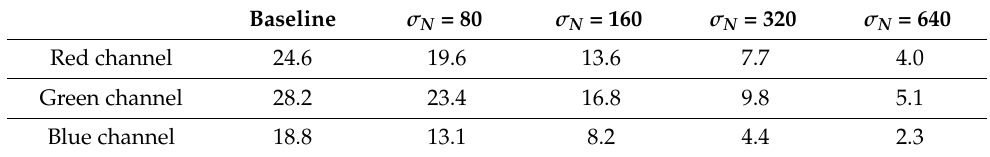
Table 3. Signal-to-noise ratio (SNR) resulting from adding Gaussian noise to the raw images with standard deviation σ N at 80, 160, 320, and 640,